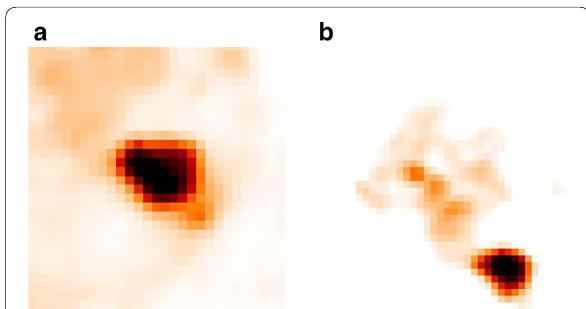
Fig. 1 Two examples of a bounding box: A large bounding box is drawn around each lesion so that it also includes a large amount of background. For each lesion, the lesion is placed in a different position in the bounding box such that the CNN is not learning mainly the position of the lesion in the bounding box. On the left ( a ), the lesion is placed in the middle of the box, while on the right ( b ), the lesion is placed at the lower right